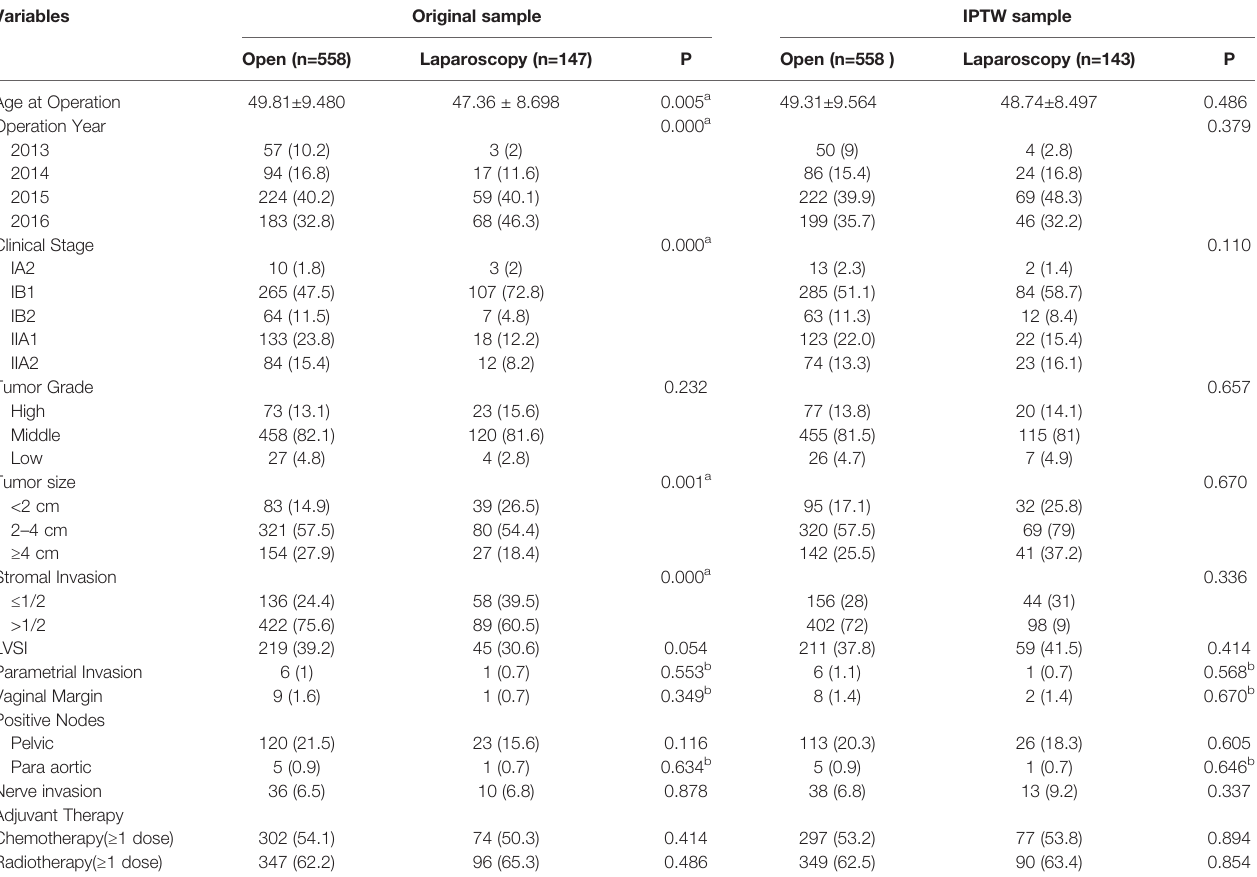
FIGO, Federation International of Gynecology and Obstetrics; IPTW, Inverse Probability of Treatment Weighting; LVSI, lymphovascular space invasion; a P<0.05; b Fisher exact examination.